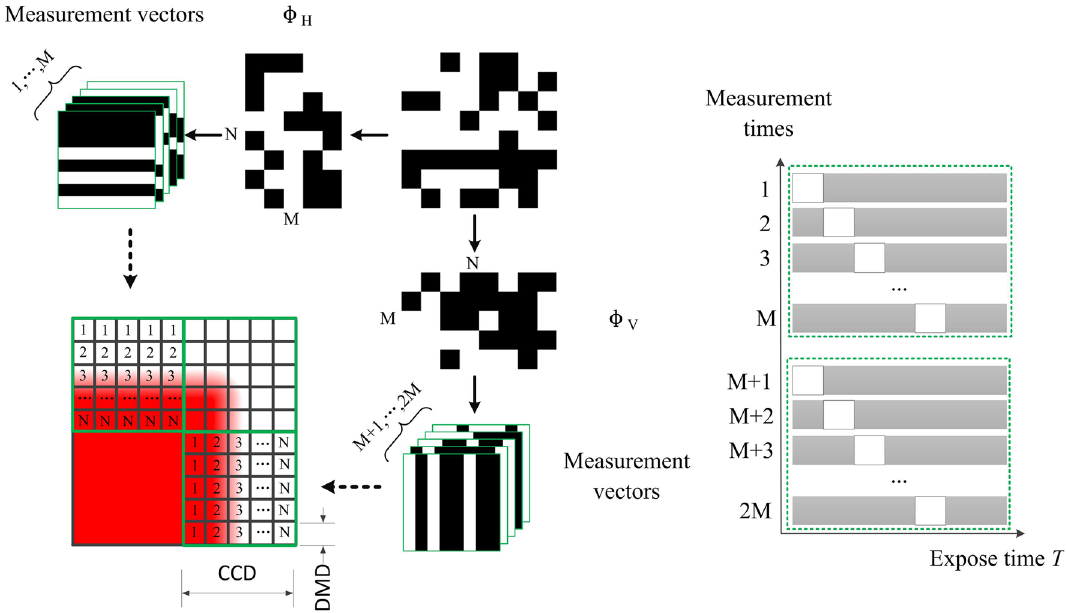
Figure 3. The CS-based imaging schematic of DMD